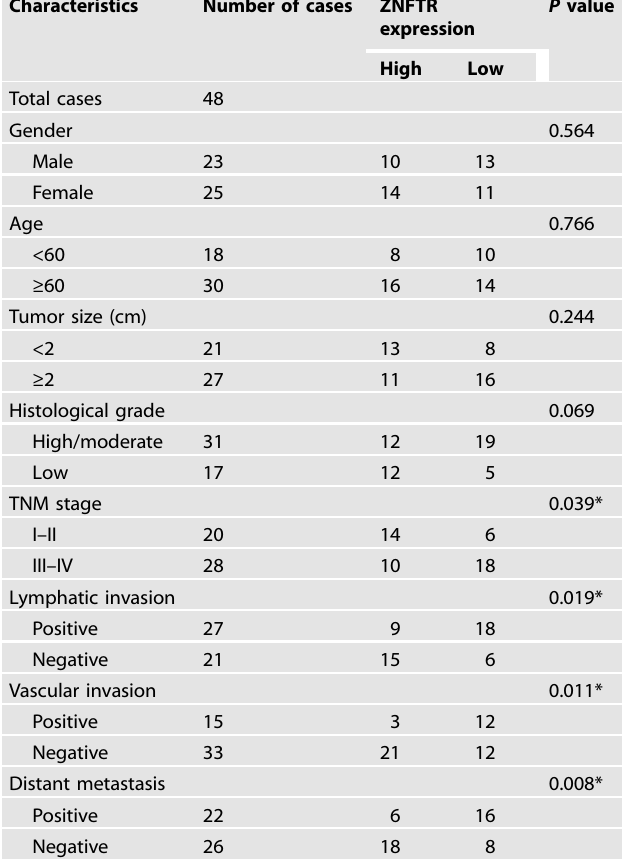
Table 1. Correlation between ZNFTR and clinical characteristics of patient with pancreatic